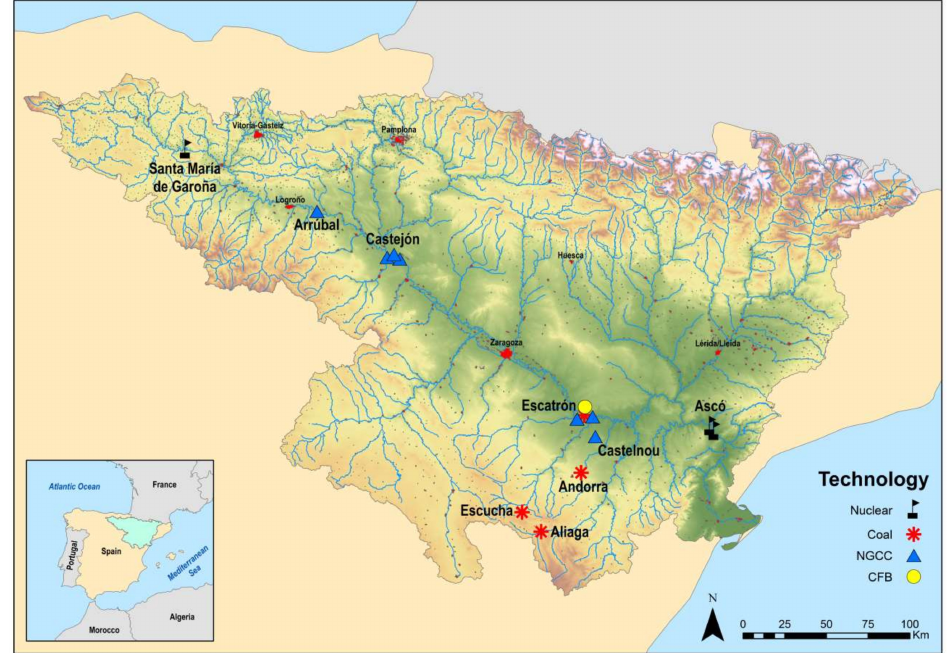
Figure 1. Thermoelectric power plants in the Ebro River basin by type of technology, 1950–2017. Note: NGCC = Natural Gas Combined-Cycle; CFB = Circulating Fluidized Bed. Source: own design using data from the Ebro Hydrographic Confederation and the Spanish National Geographic